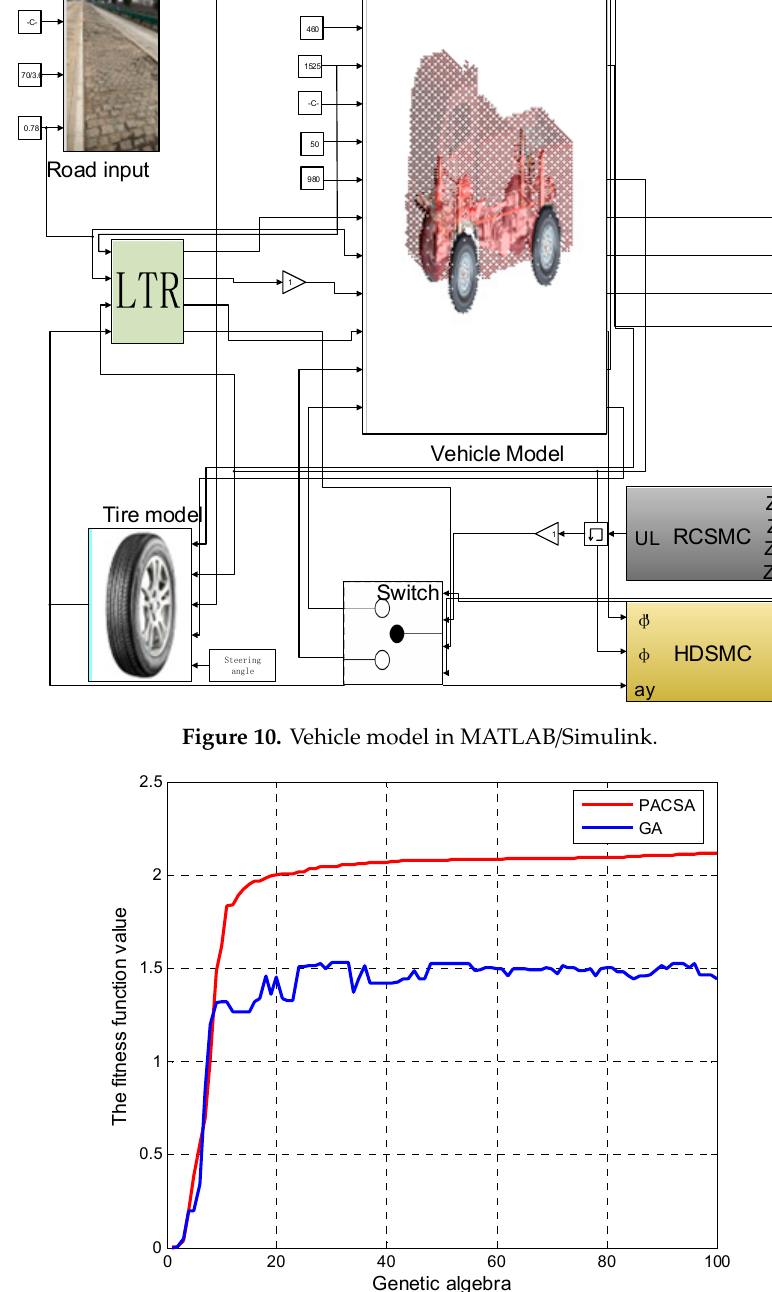
Figure 11. The relationships between the fitness functions value and the genetic generation of GAand